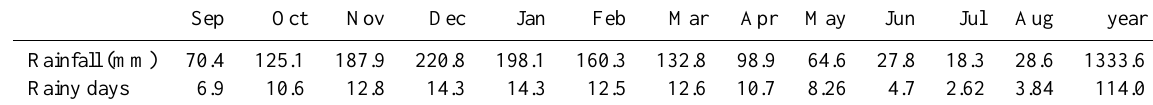
Table 3. Average monthly rainfall and number of rainy days at the Montalto Uffugo rain gauge (468m a.s.l.).